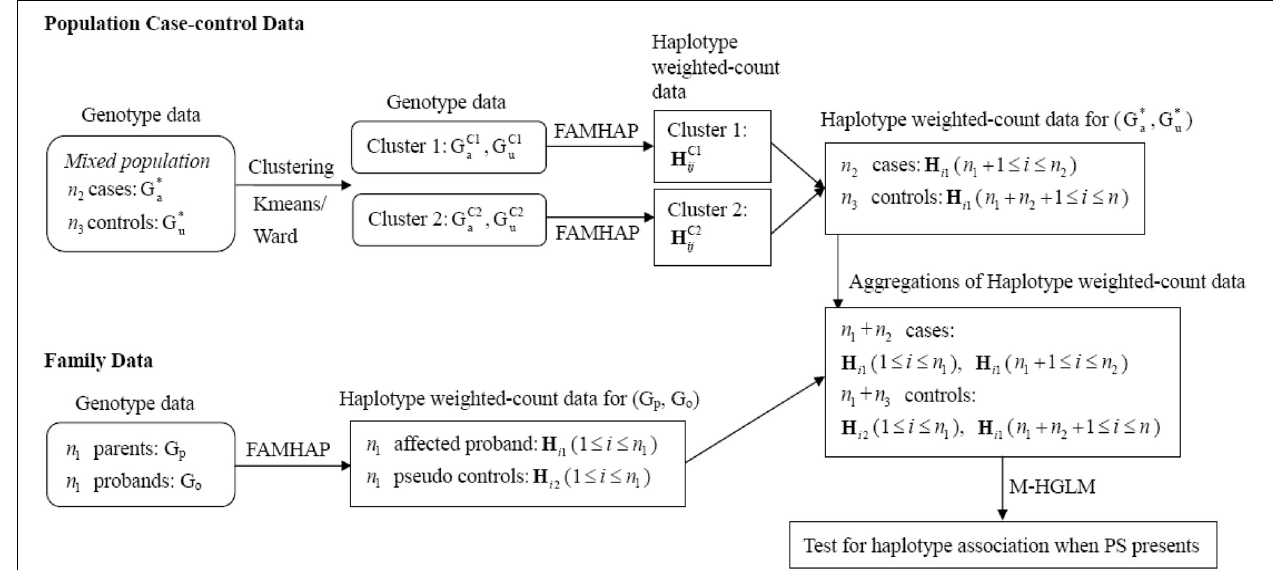
FIGURE 2 | SchematicdiagramofM-HGLMforcombiningdataofclusteredcase-controlsamplesandfamilytrioswhenPSpresents.H C1 ij and H C2 ij denote thehaplotypeweighted-countobtainedfromclusters1and2,respectively,whenperformingclusteringmethodsonmixedpopulationcase-controlgenotypedata.